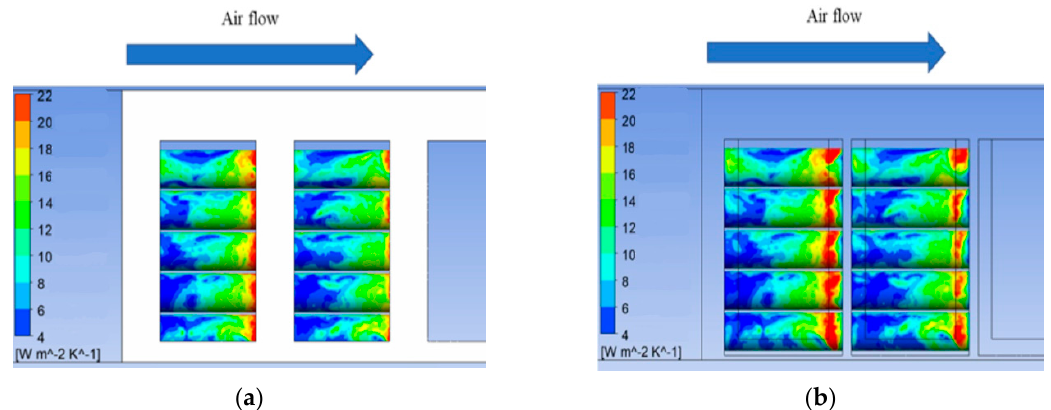
Figure 6. Distribution of the heat transfer coefficient on the cells’ surface ( a ) with visible battery segment housing; ( b ) with hidden battery segment housing.